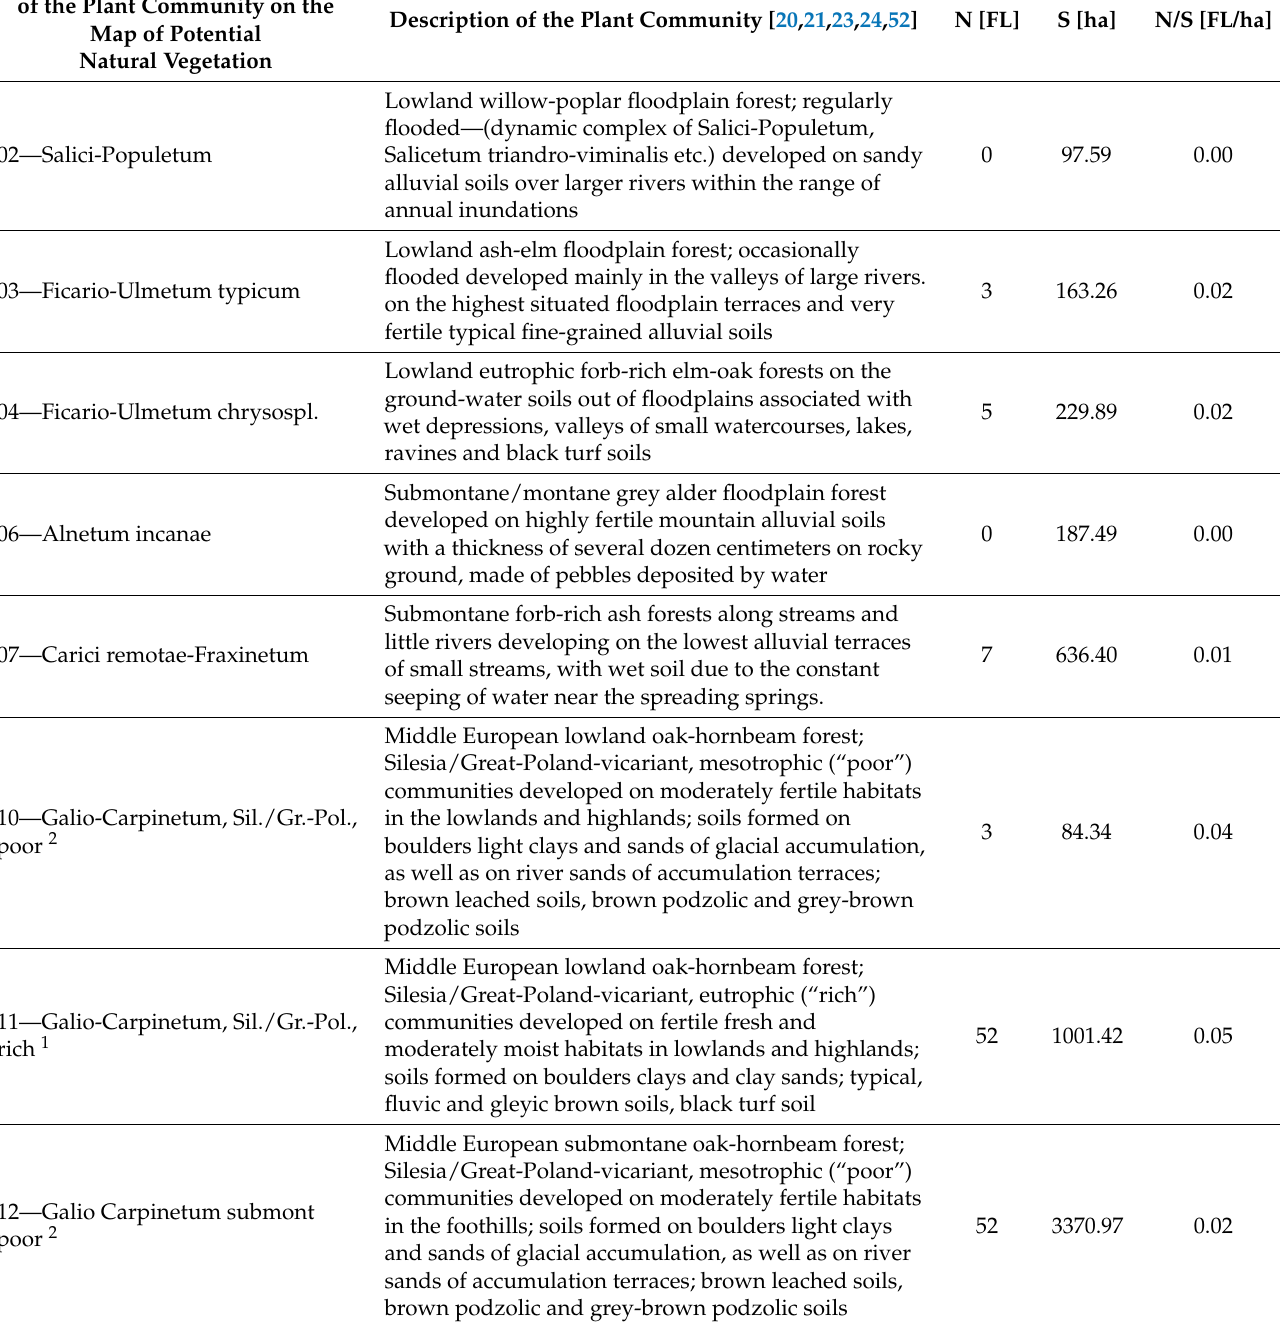
Table 2. Number (N) of fir localities (FL) (in the area covered by the study) within individual areas of potential natural vegetation (PNV, their (PNV) surface area (S) and the number of fir localities (FL) per unit of surface area